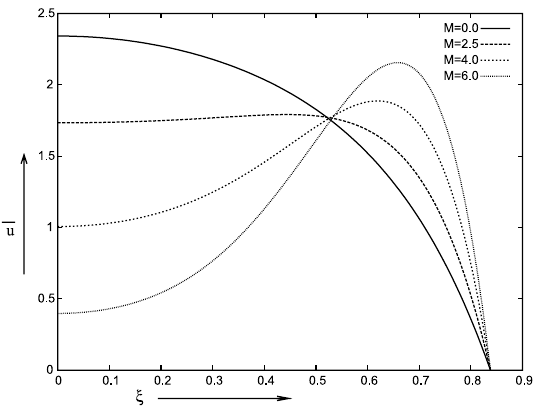
Fig. 6. Velocity distribution at z = 2 . 0 for different values of M , when H = 0 . 2, β = 2 . 5, α = 0 . 09 and k = 0 . 25.